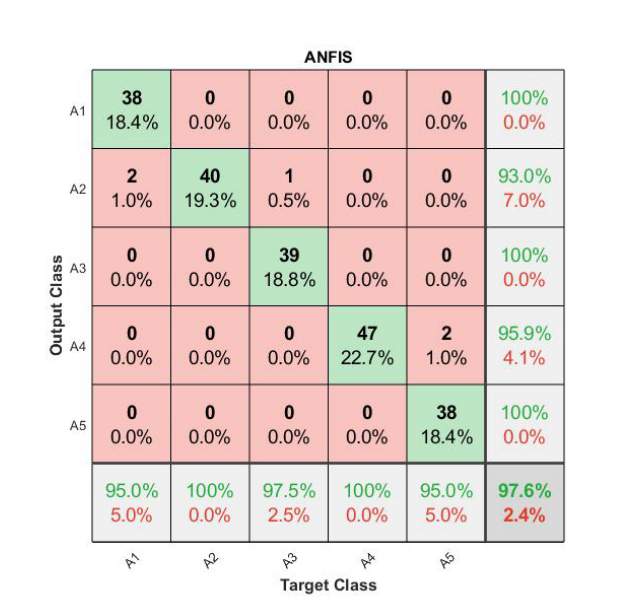
Figure A7. First instance results.